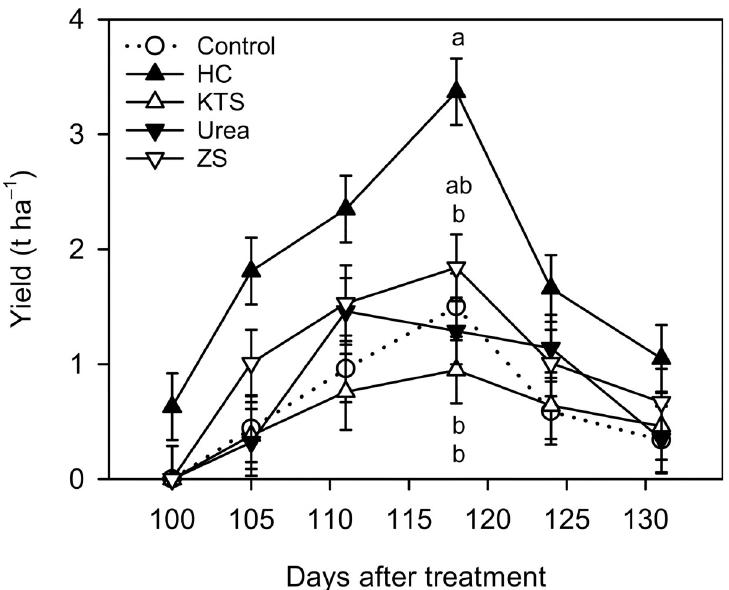
Fig 2. Weekly yield of ‘Emerald’ blueberry grown under inadequate chilling conditions as affected by hydrogen cyanamide (HC) and defoliants in the 2018–2019 season (Expt. 1). Treatments are as described in Fig 1. Means (n = 3–4) with the same or no letter within each measurement day are not significantly different (Tukey–Kramer test, P < 0.05). KTS = potassium thiosulfate; ZS = zinc sulfate.